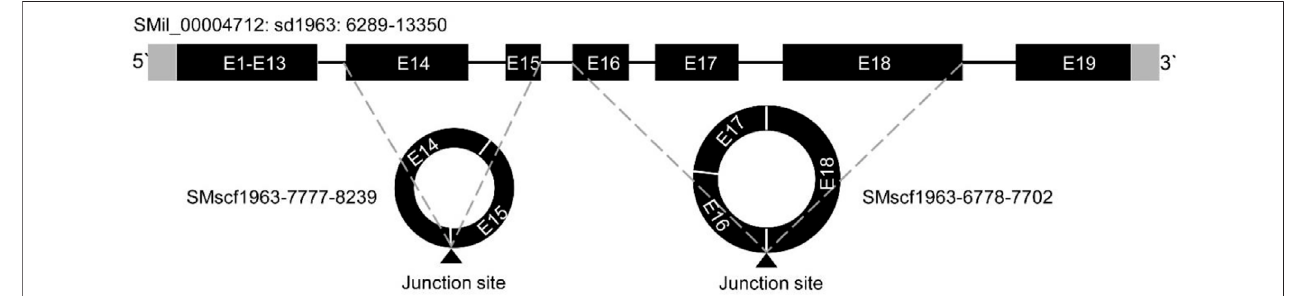
FIGURE 3 | Schematic representation of the alternative circularization of gene SMil_00004712 in S. miltiorrhiza . The structure of the parent genes is based on that described previously (Xu et al., 2016). The gray and black rectangles represent untranslated regions (UTR) and exons, respectively. The thin lines between the exons represent introns. The two circles represent two circRNAs SMscf 1963-7777-8239, and SMscf 1963-6778-7702 derived the gene. The exons are labeled with “ E ” followed bythenumber ofthe exons. Theblack trianglesunder thecircles indicate the junction sites. Thedashed lines indicate the positions ofthe junction sites on the genomic